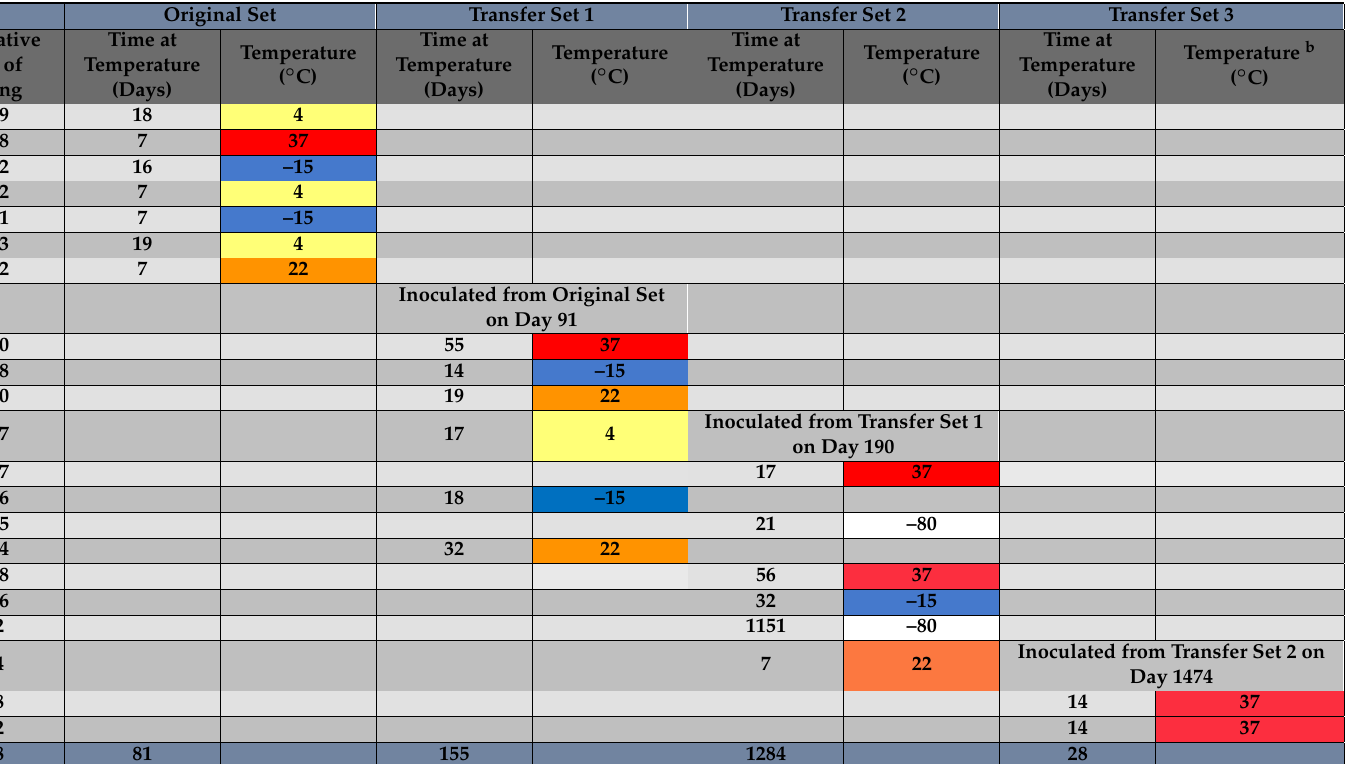
Table 3. Time intervals and temperatures for freeze/thaw cycling for Experiment 3 for Methanobacterium formicicum cultures.